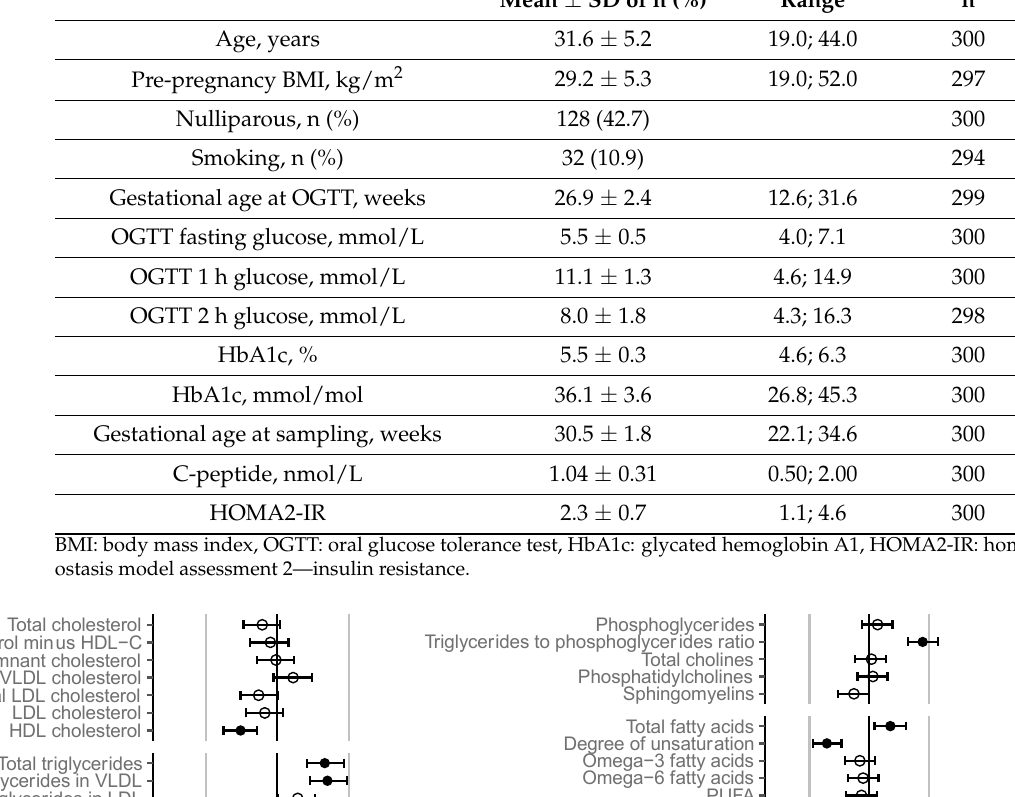
Table 1. Population characteristics.